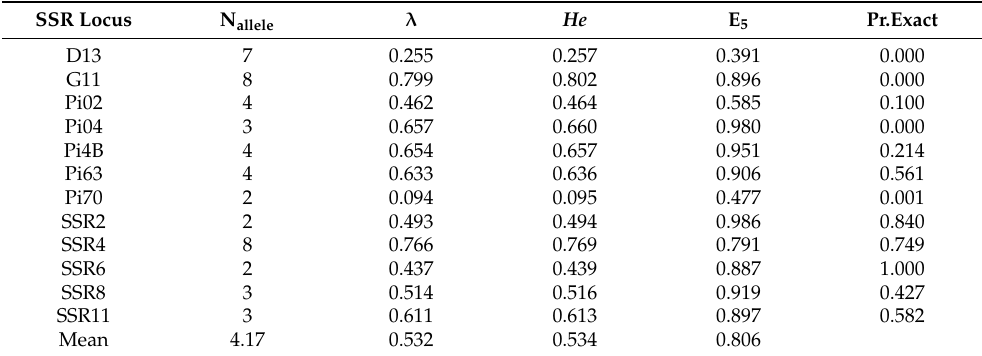
Table 2. Population genetic parameters for P. infestans over all sampling sites for 12 SSR loci. SSR Locus N allele λ